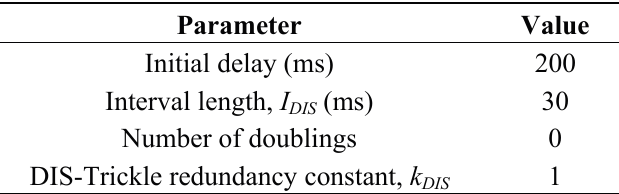
Table 3. DIS-Trickle parameter